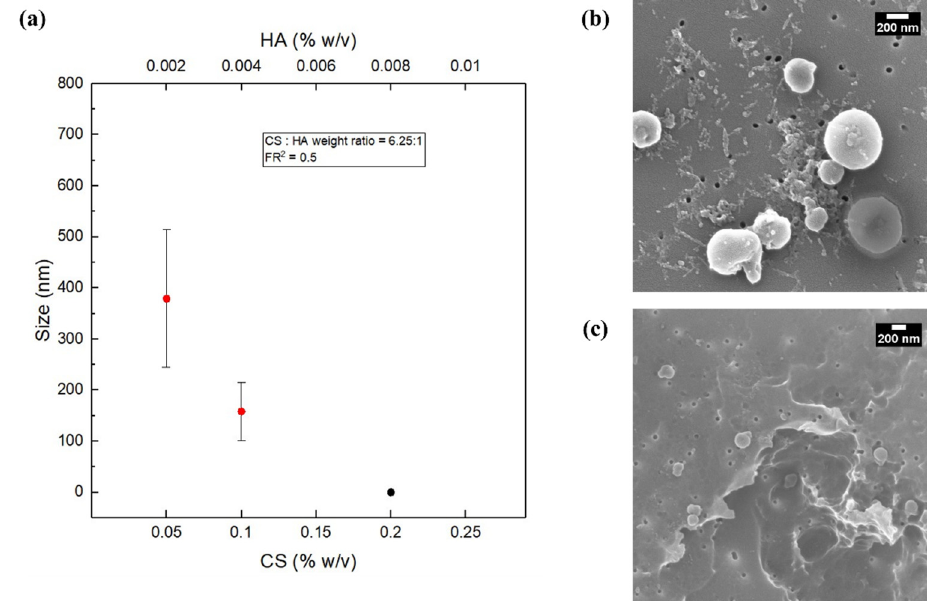
Figure 2. NPs’ size and morphology at constant polymer ratio reproducing batch conditions: ( a ) Plot showing size vs. CS and HA concentrations at CS: HA weight ratio equal to 6.25 at low flow rate regime (MFR = 0.3 μ L/min and SFR = 0.6 μ L/min). The black point indicates that only macroaggre- gates and unreacted materials are obtained, therefore the size was not measurable (see Figure S3 of the Supplementary Material); ( b ) CS = 0.05 % w / v ; ( c ) CS = 0.1 % w / v .